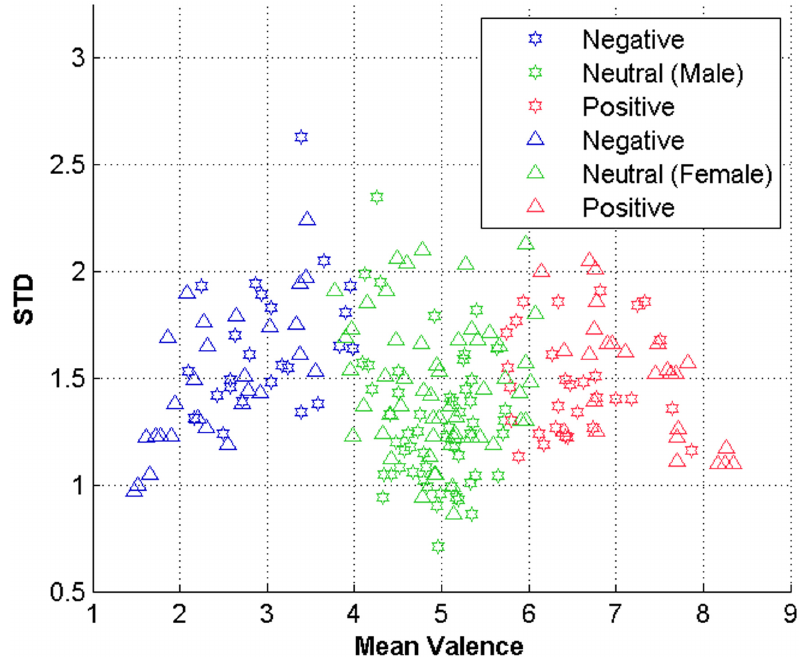
Fig 2. Valence categories and genders. To show the existence of differences between male and female genders, a fuzzy c-means is run to categorize the images based on their mean valence and standard deviation into three classes of unpleasant, neutral, and pleasant. Comparing gender specific results, the disagreement of genders on valence is evident.